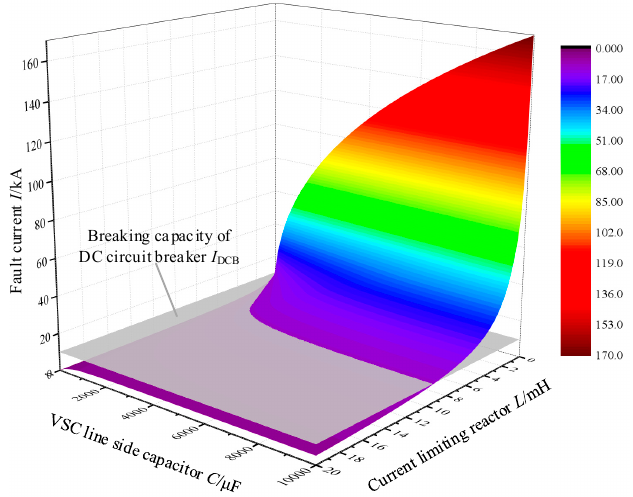
Figure 7. Effect of VSC line side capacitor and current limiting reactor ( C , L (VSC) ) on the fault current of DC circuit breaker.